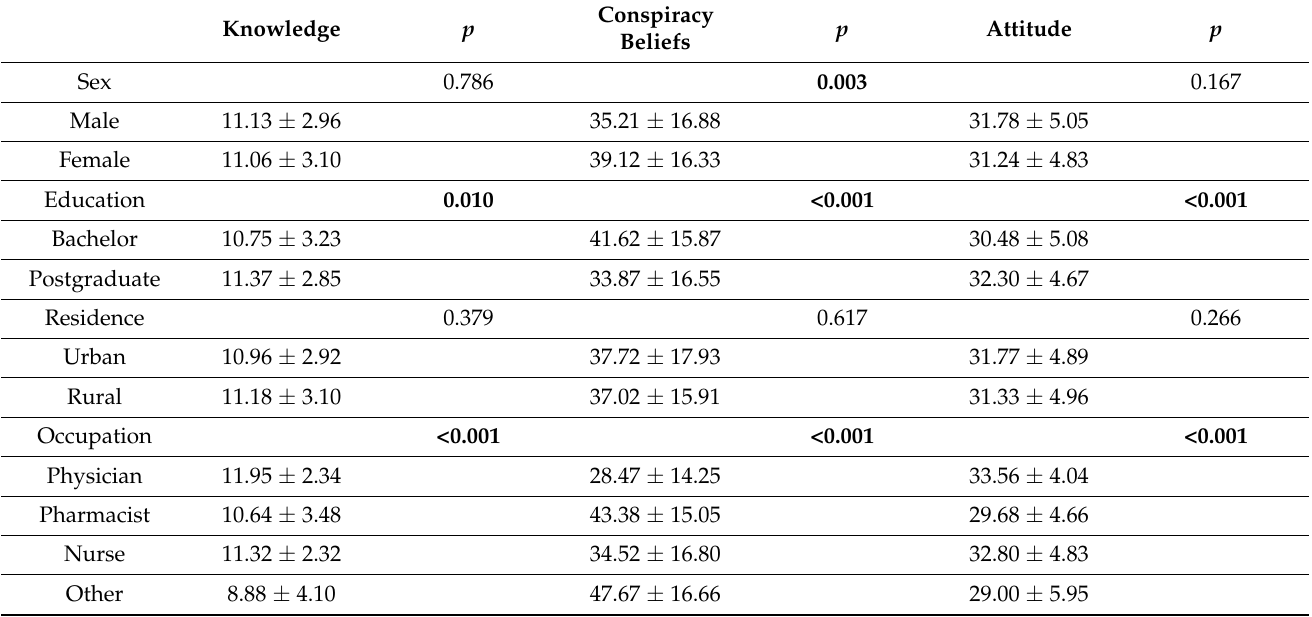
Table 5. Bivariate analysis of factors associated with the knowledge, conspiracy beliefs, and atti- tude scores.